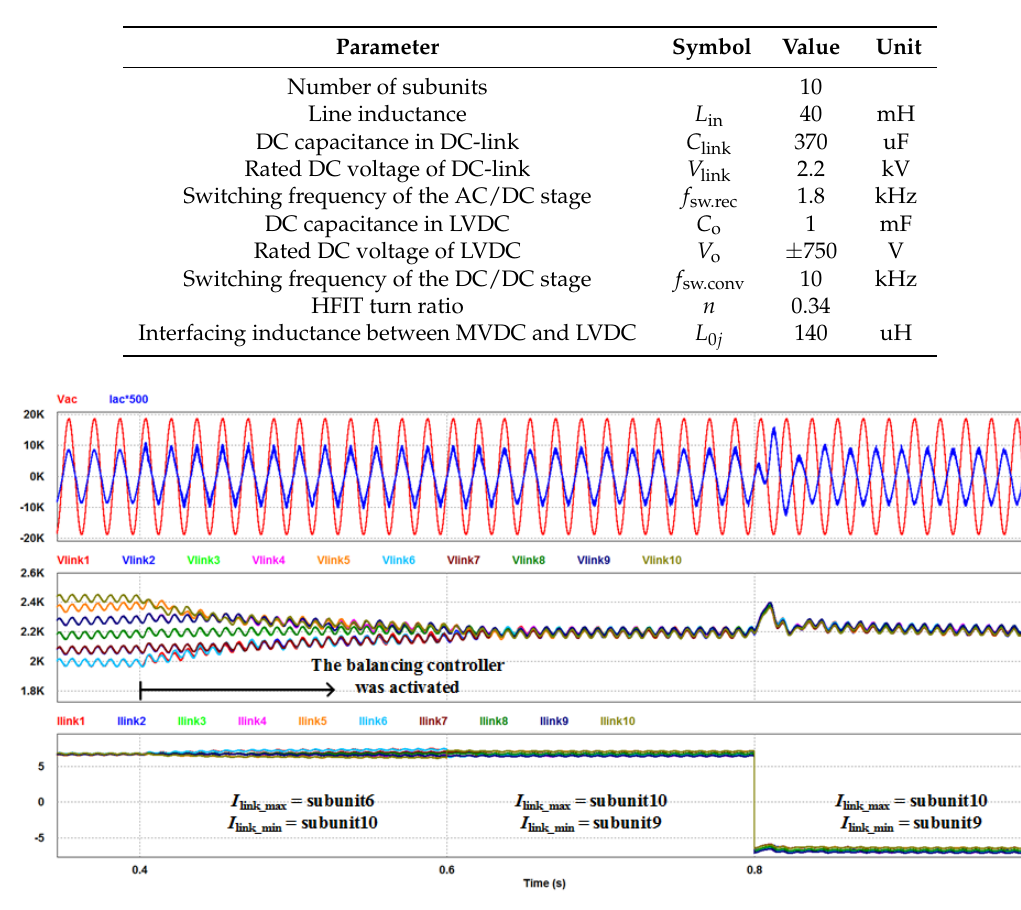
Table 1. System parameters.